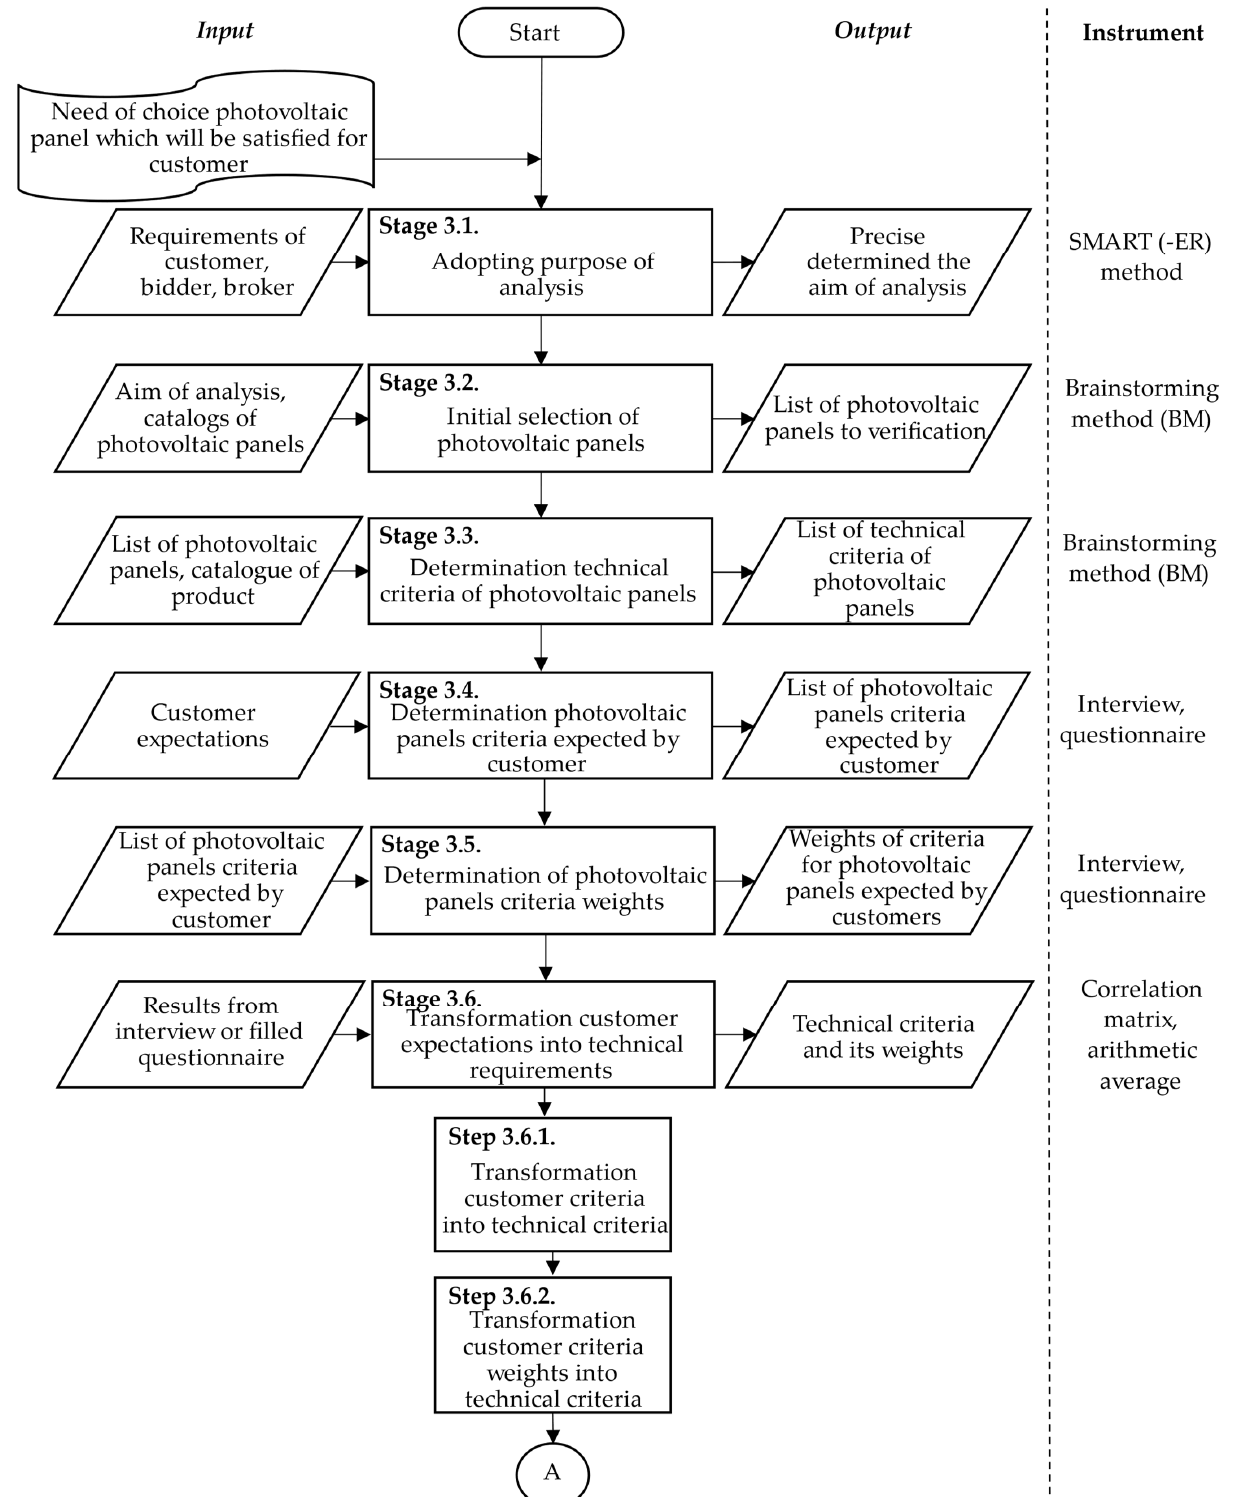
Figure 2. Model of choosing the most favorable photovoltaic panel—part 1. Own study.